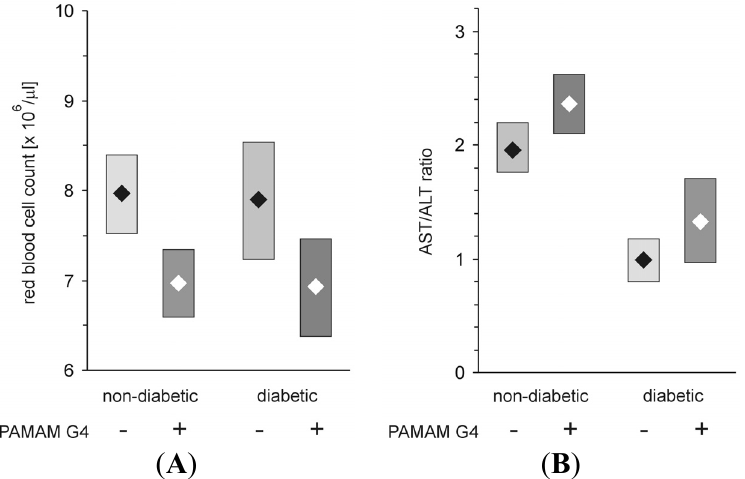
Figure 16. Effect of administration of PAMAM G4 on red blood cell count and aspartate aminotransferase/alanine aminotransferase activity ratio (AST/ALT ratio, De Ritis